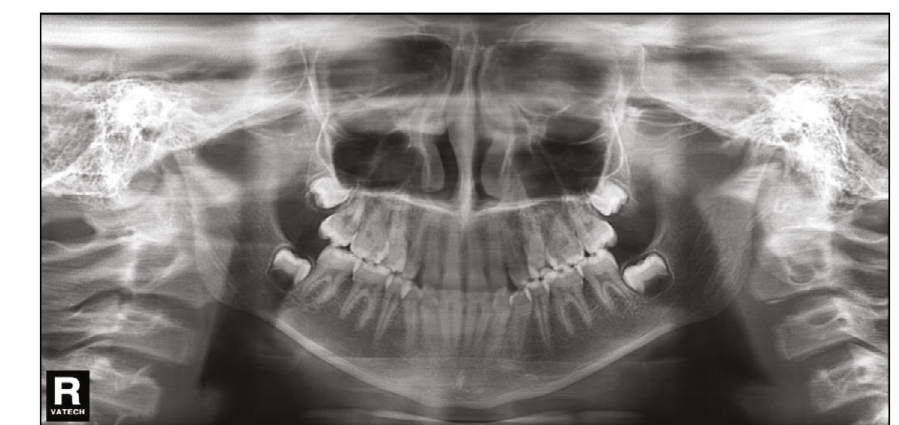
Figure 3: Pretreatment panoramic radiograph.